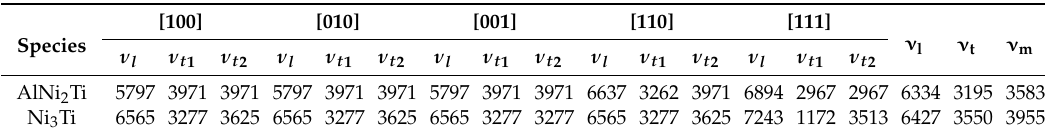
Table 3. Calculated anisotropic sound velocities of AlNi 2 Ti intermetallic compounds, together with the values of Ni 3 Ti. The unit of velocity is